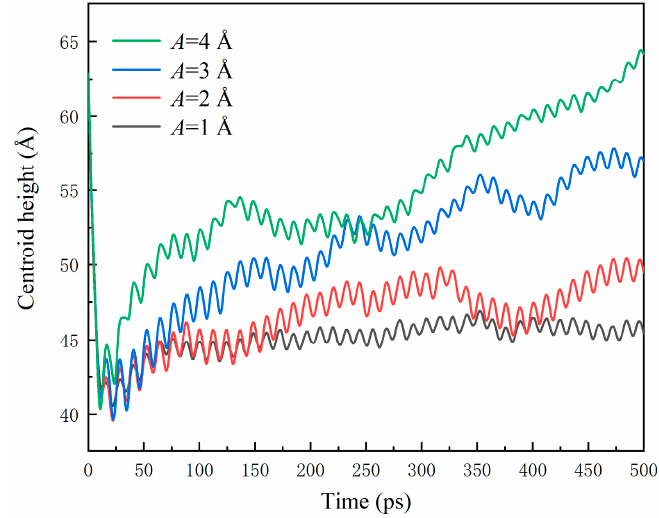
Figure 13. Centroid height of water nanodroplets impinging on vibration surfaces with various amplitudes.